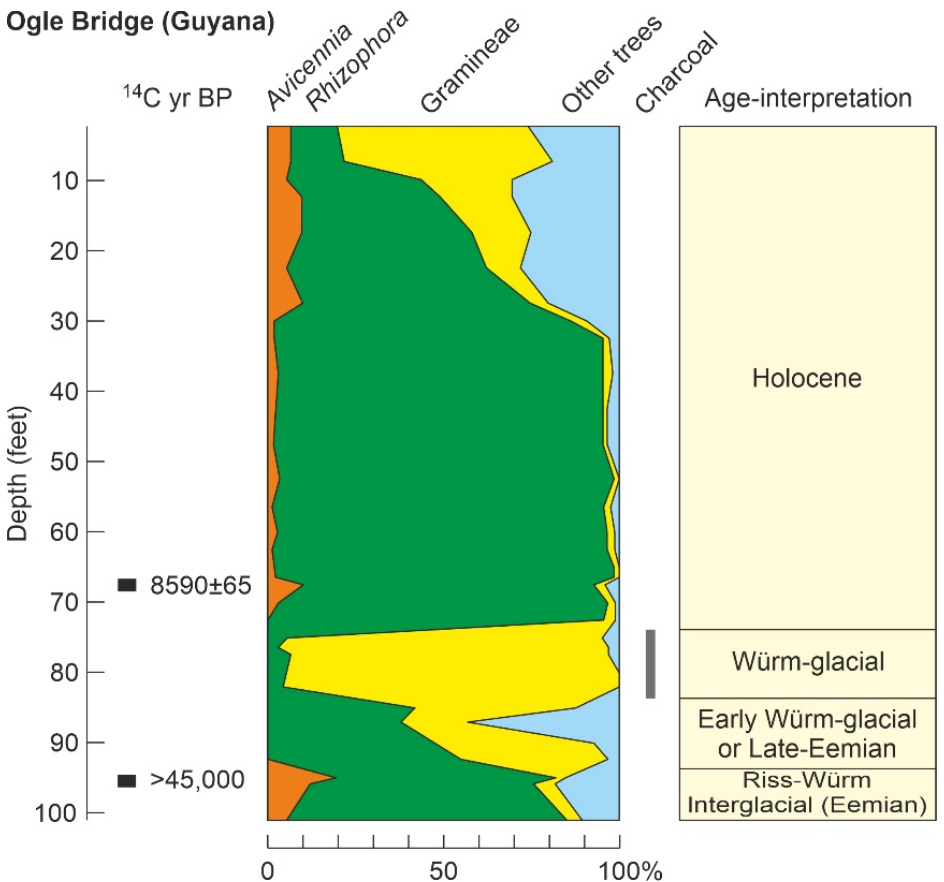
Figure 14. Summary pollen diagram from the Ogle Bridge section (Guyana) and chronological interpretation, according to the original Ref. [131]. Other trees include Alnus , Ilex , Symphonia , Virola , Mauritia, and other palms. Redrawn from Ref. [131].